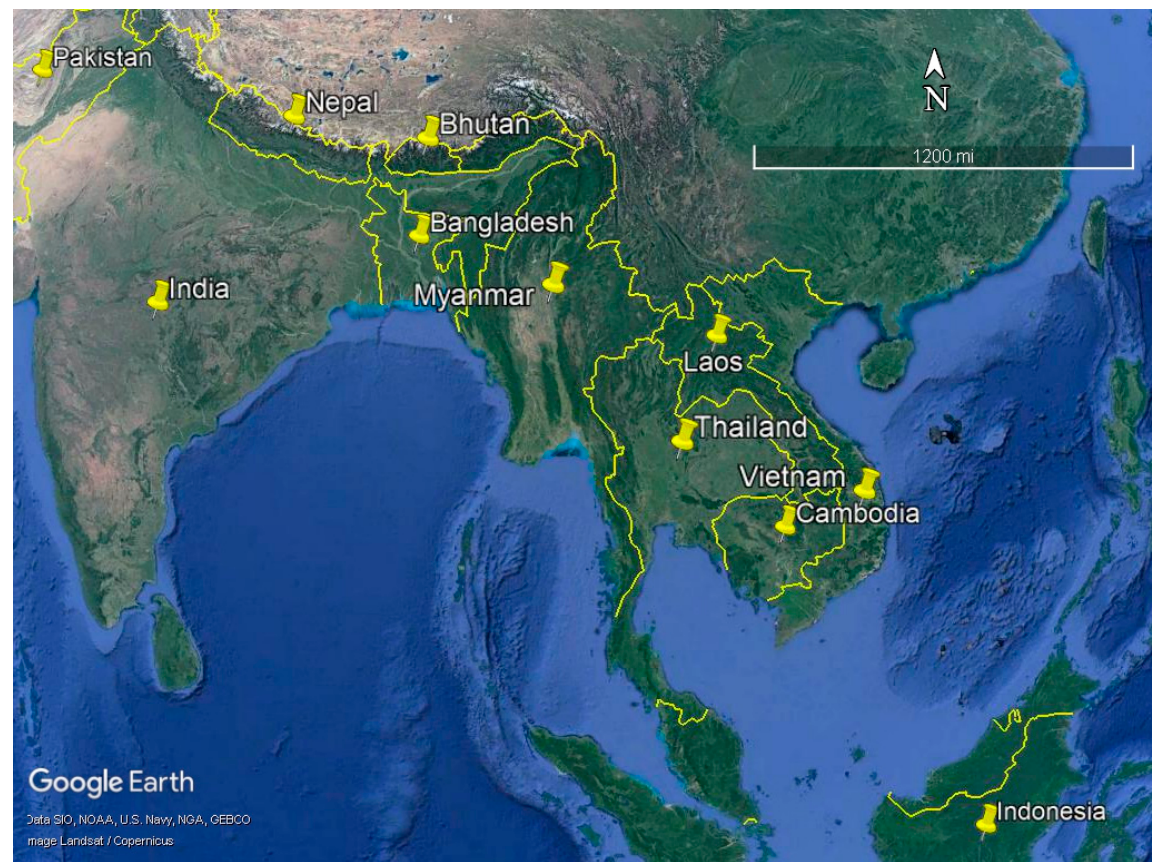
Figure 2. Worldwide distribution of Bagarius bagarius (Source: Google Earth Pro). The literature of the last two decades that recorded the distribution of this species in the waterbodies of Bangladesh is listed in Table 2, and district-wise distribution is pre- sented in Figure 3. Table 2. Distribution of Bagarius bagarius in Bangladeshi waters.